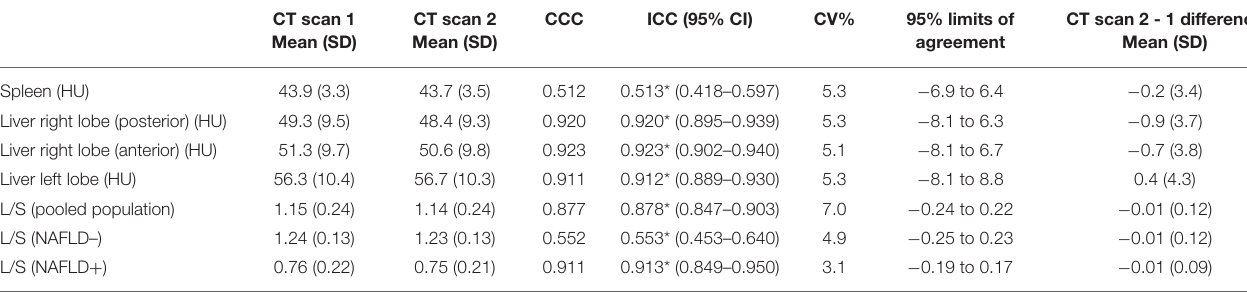
TABLE 2 | Repeatability (test-retest) of parameters defined from the low-dose computed